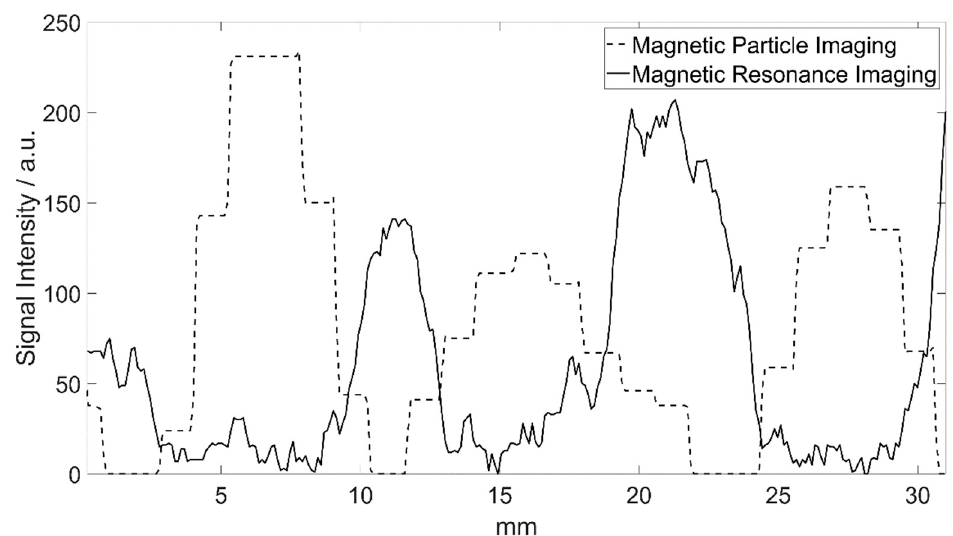
Figure 6. Signal intensity plots of the reconstructed images of both modalities (Figure 4B,C) along the direction of the guidewire. Areas of high signal intensity in MPI are represented as signal loss in MRI. The distances of the maxima/minima of both signal intensity curves correlate very well with the real marker spacing.